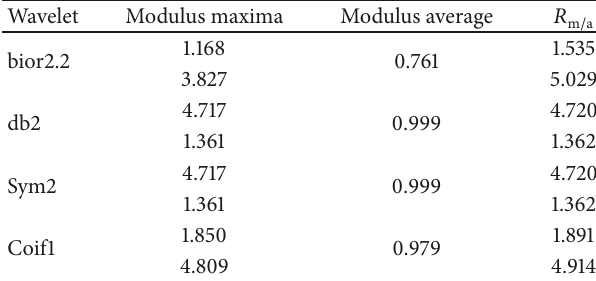
Table 1: 𝑅 m / a of the jump points at both ends of the